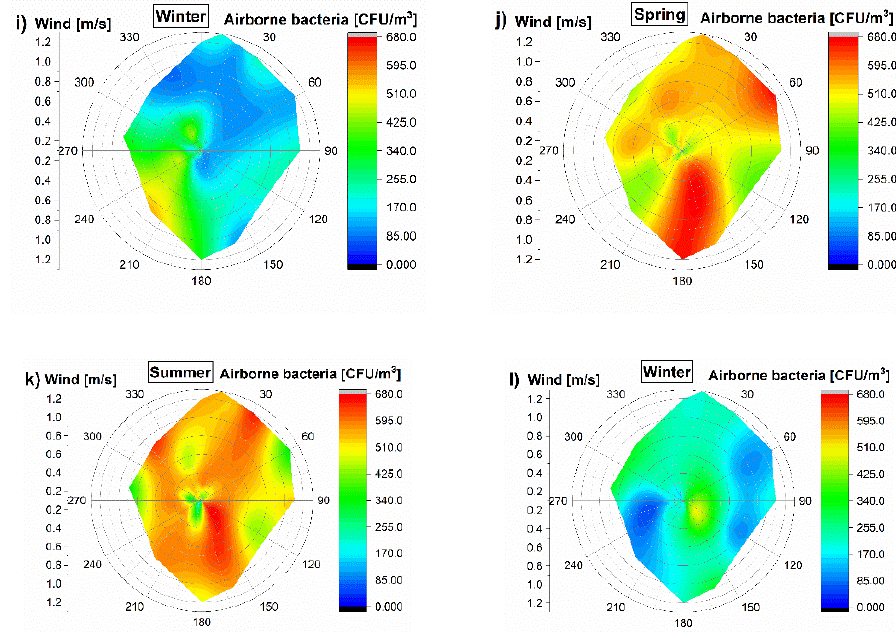
Figure 2. Polar contour maps for the concentrations of outdoor aerosol (PM 10 and airborne bacteria) as a function of wind speed and direction. ( a – c ), ( g – i ) are investigated for 20 days in 2015; ( d – f ), ( j – l ) are